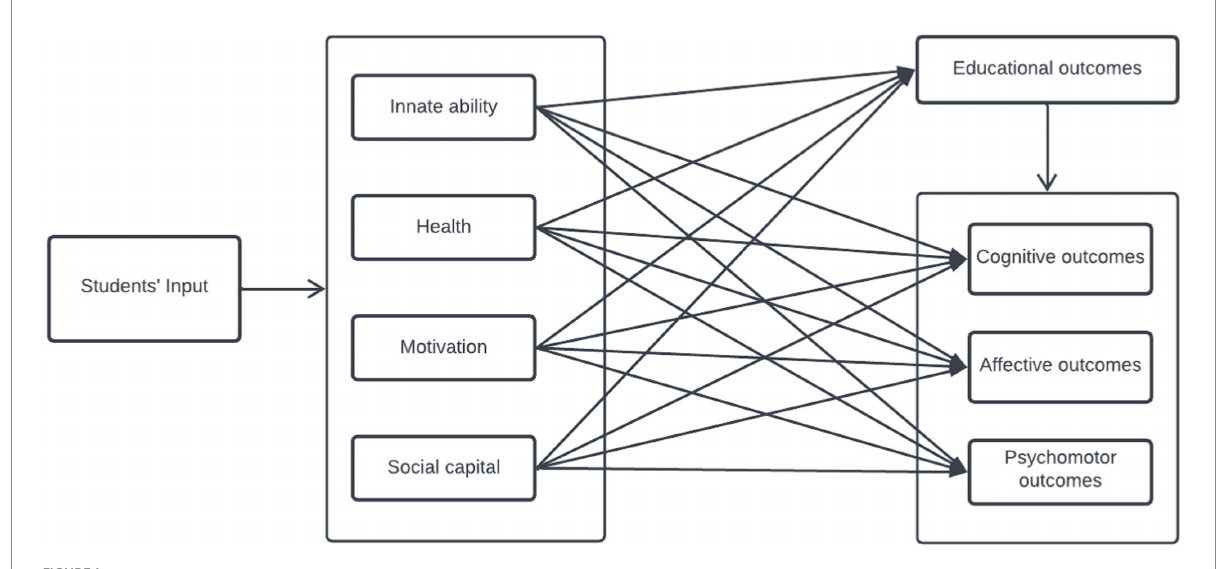
FIGURE 1 Conceptual model of the study showing the predictive and criterion